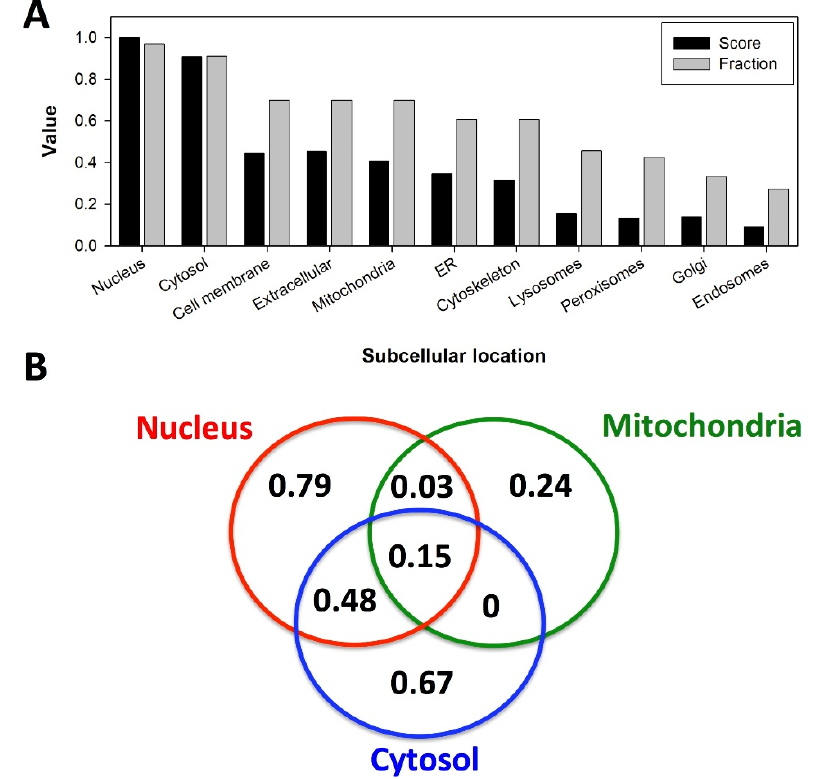
Figure 5. Subcellular location of NQO1 interacting human partners based on data from GeneCards ® (https://www.genecards.org/, accessed on 1 April 2022). For all the interactors, the subcellular compartment (location) and its confidence (1–5, from the lowest to the highest) were retrieved from GeneCards ® . ( A ) Accumulated score for each organelle as the sum of the numerical degree of confidence for all partners found in a given compartment. The highest accumulated score (i.e., for the nucleus) was used to normalize yielding the Score . As Fraction , we refer to the fraction of all the partners found in a given organelle. Note that the ratio Score:Fraction gives a measure of the degree of confidence for finding a given partner in a given subcellular location. ( B ) Subcellular location of NQO1 partners in the three subcellular locations of NQO1 reported with confidence (i.e., equal or higher than 3) as the fraction of the total of NQO1 partners. Overlapping regions in the Venn diagram reveal the presence of an NQO1 partner in at least two subcellular locations. Numbers in the different regions of the Venn diagram represent the fraction of NQO1 partners present in different subcellular